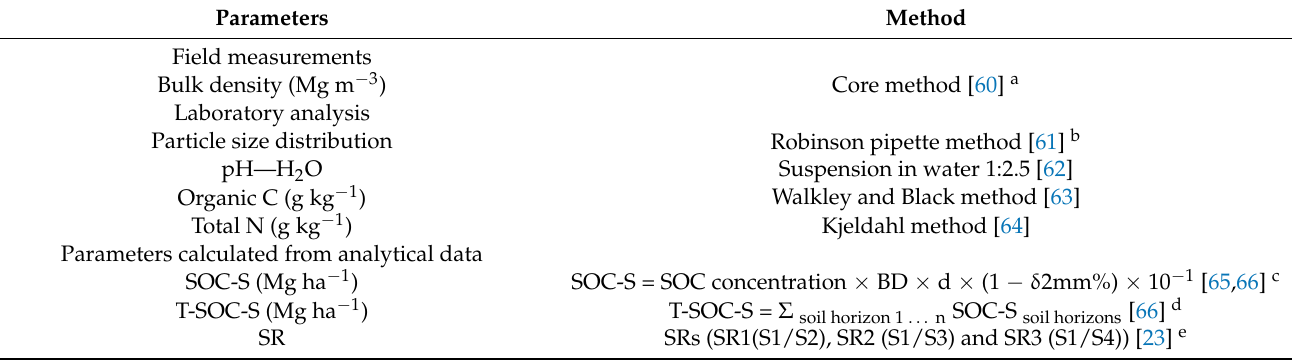
Table 3. Analytical methods used in this study (field measurements, laboratory analysis, and parameters